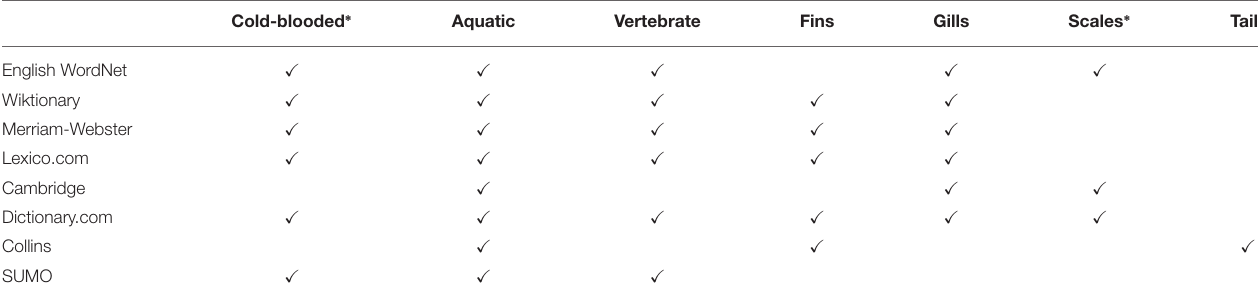
TABLE 3 | Analysis of listed differentiae for the sense of “fish” as an animal in different